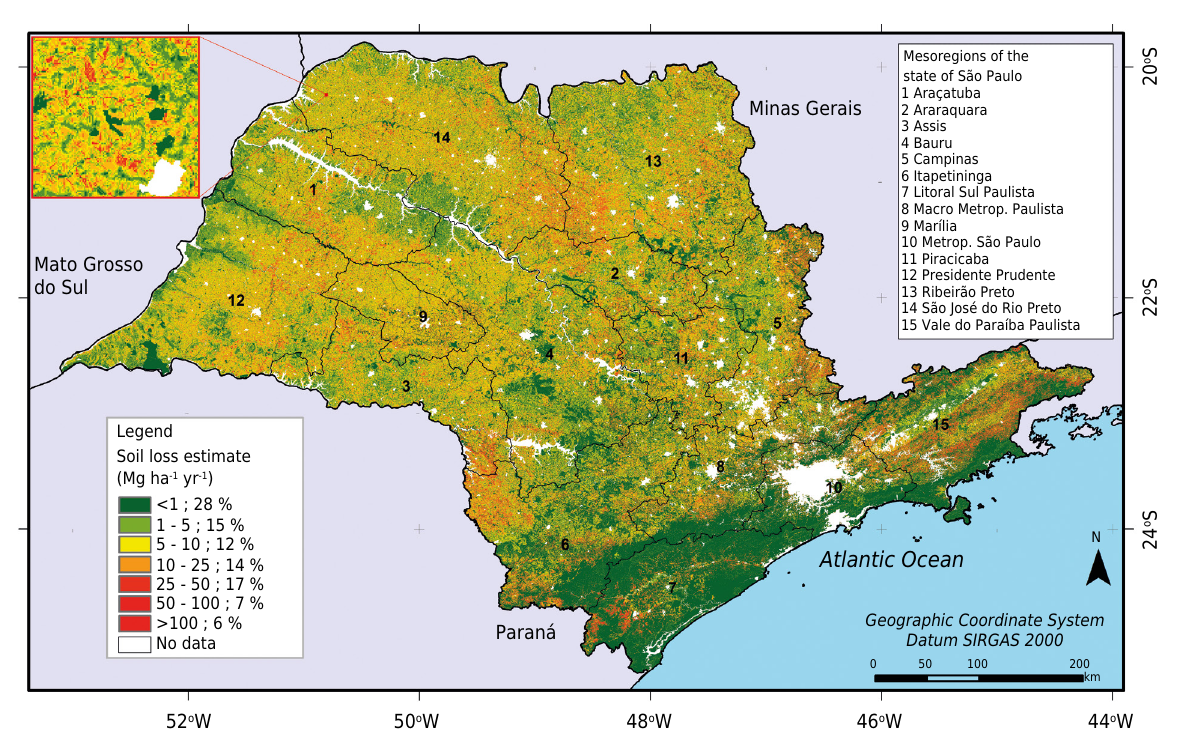
Figure 10. Map of estimated annual rates of soil loss of the state of São